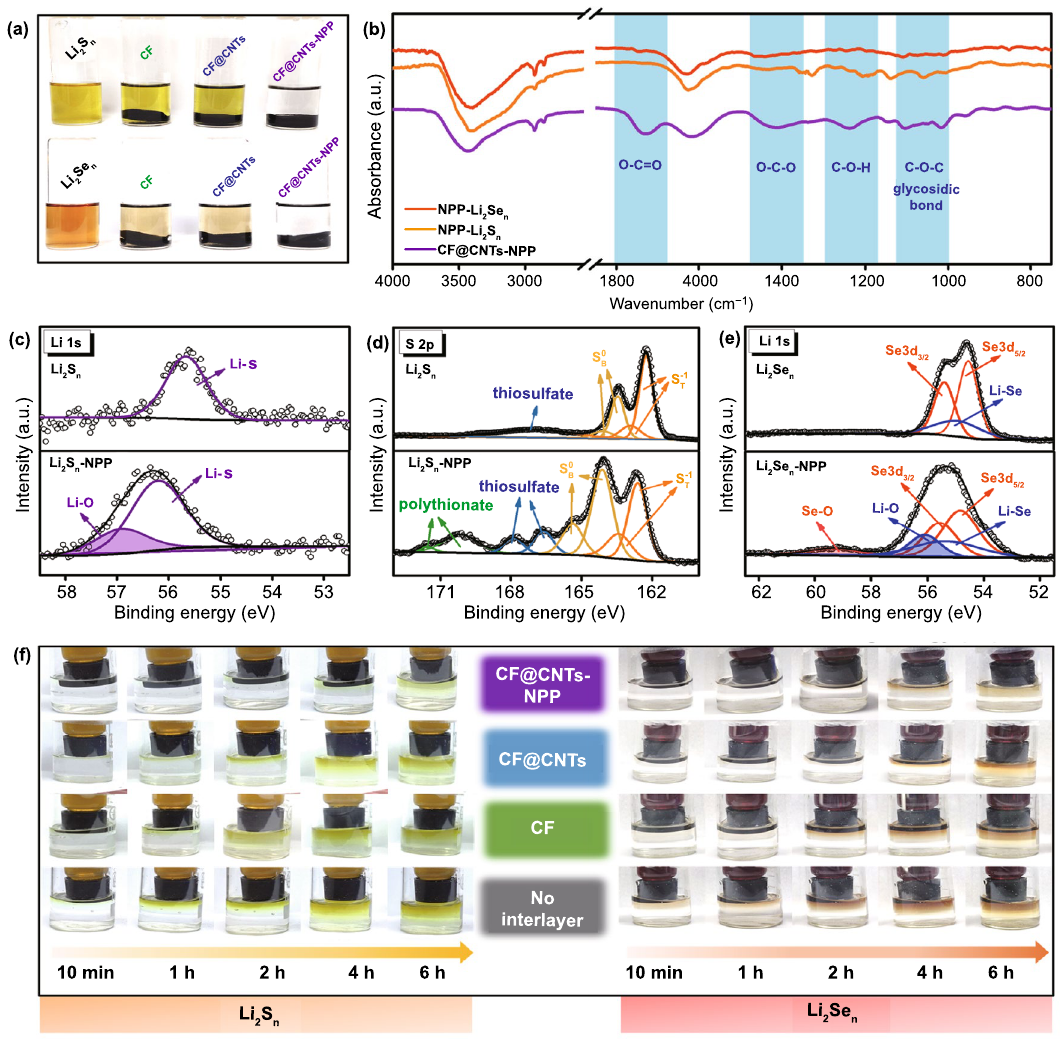
Fig. 3 a Optical photographs of Li 2 S n and Li 2 Se n solutions contacted with CF, CF@CNTs, and CF@CNTs-NPP after 12 h. b FT-IR spectra of CF@CNTs-NPP, Li 2 S n -NPP, and Li 2 Se n -NPP. High-resolution XPS c Li 1s and d S 2p spectra of Li 2 S n and Li 2 S n -NPP. e High-resolution XPS Li 1s spectra of Li 2 Se n and Li 2 Se n -NPP. f Digital photographs of Li 2 S n (left) and Li 2 Se n (right) diffusion at different rest